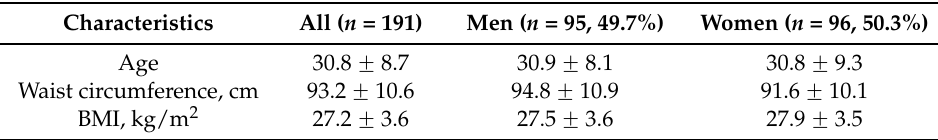
Table 1. Characteristics of the study participants at baseline ( n =